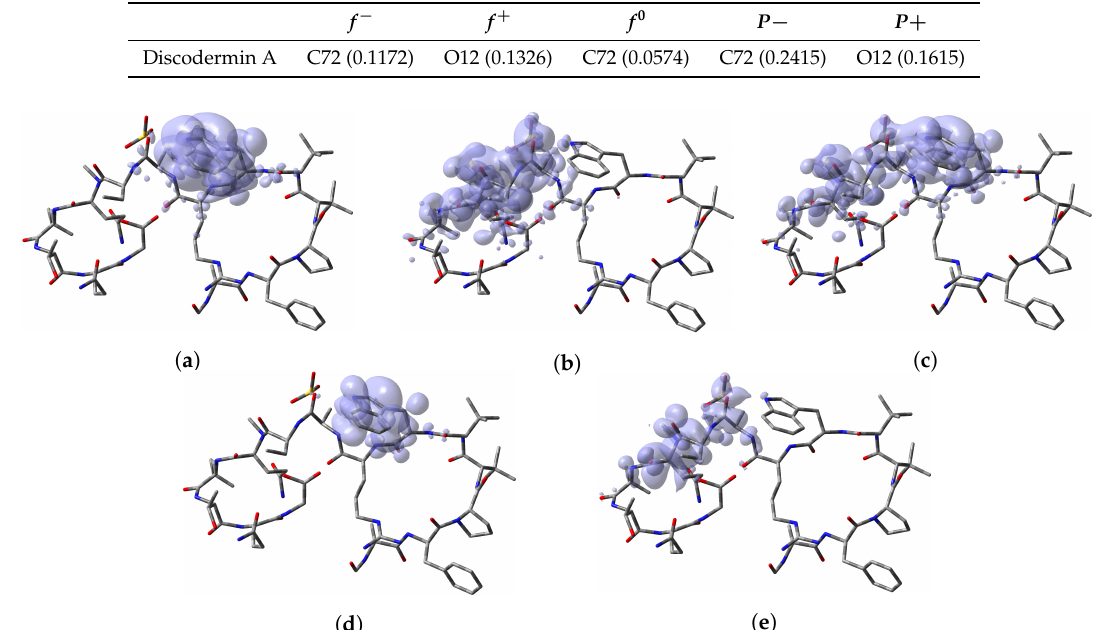
Table A1. Condensed local reactivity descriptors for Discodermin A denoting the reactivity sites: Electrophilic Fukui Function f − , Nucleophilic Fukui Function f + , Radical Fukui Function f 0 , Electrophilic Parr Function P − and Nucleophilic Parr Function P + .